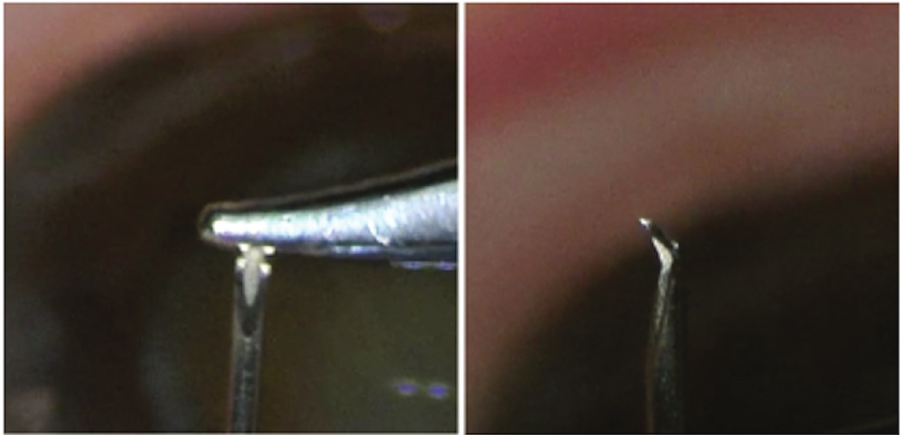
Figure 1. Fashioning a goniotome from a 25-gauge needle using a needle driver.